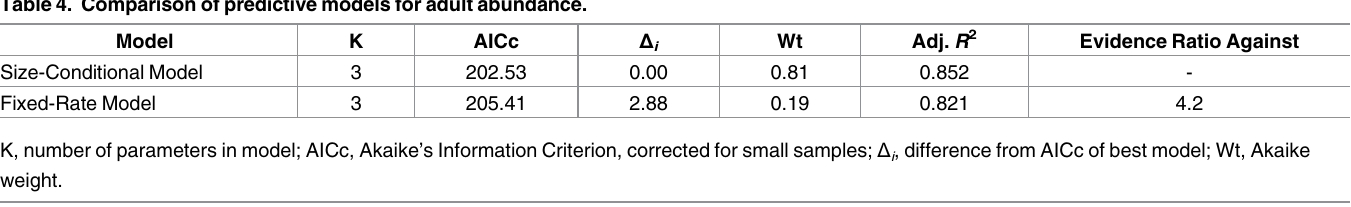
According to the size-conditional model, the composition of migrant adult steelhead shifted dramatically after 2005 (Fig 6). Before 2005, the vast majority of adults reared in the river as juveniles, but after 2005 most came from the rearing facility. This shift was driven partly by the declining growth rates of wild juveniles described earlier (Fig 4), and partly by an increase in growth rates of captively-reared fish, caused by a change in operations at the rearing facility (Fig 7). The size-conditional models suggested that without this change in operations, the steelhead run in Carmel River would be very small indeed ( i . e . small blue bars throughout Fig 6). Thus, the top-ranked model inferred a very different role for captive-rearing (supporting anadromy) than the second-ranked model (negatively associated with anadromy, ^ q = -0.0433). 2